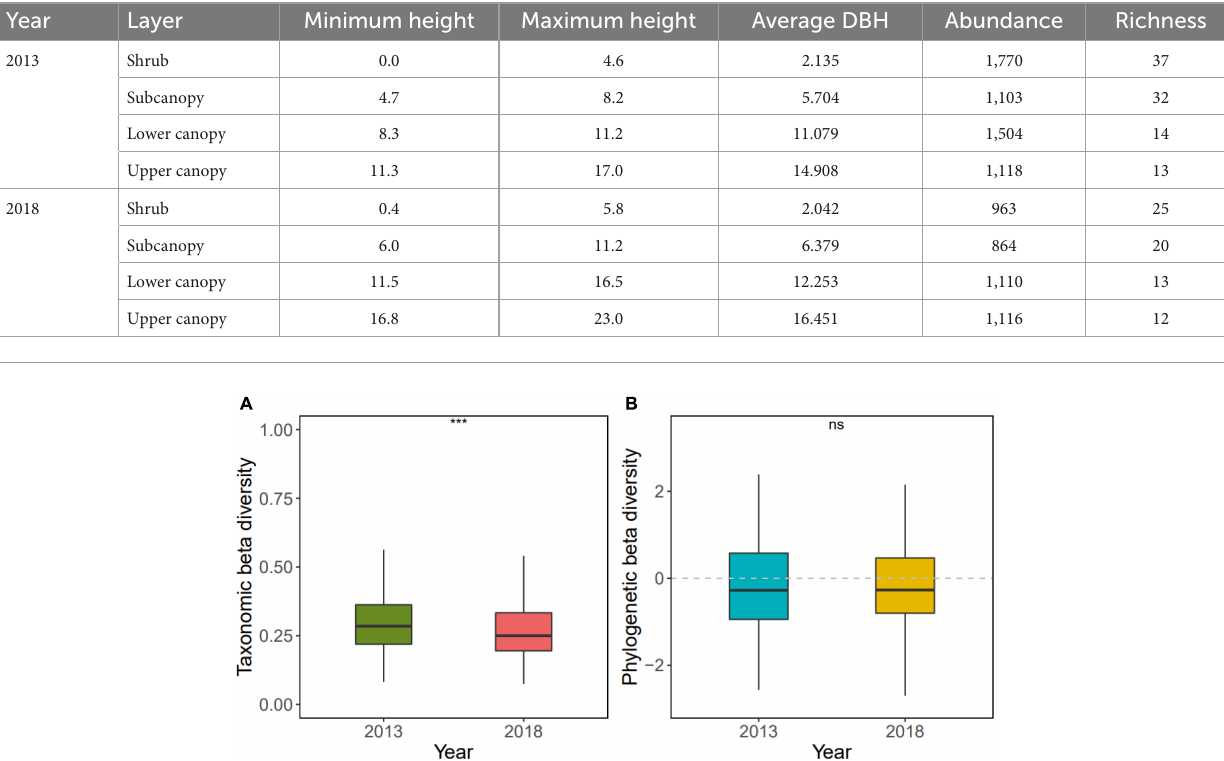
FIGURE2 Changes in taxonomic beta diversity (A) and phylogenetic beta diversity (B) in the Dongbaishan forest between 2013 and 2018. ns p > 0.05, * p ≤ 0.05, ** p ≤ 0.01, *** p ≤ 0.001, **** p ≤ 0.0001.